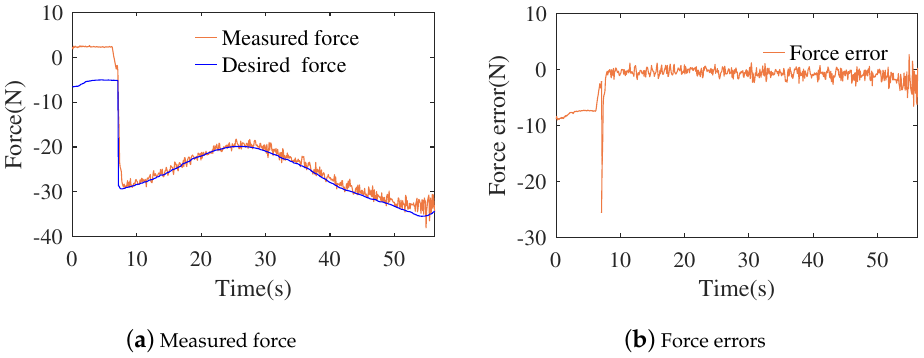
Figure 13. Measured force and force errors under robot moving from the free space under no